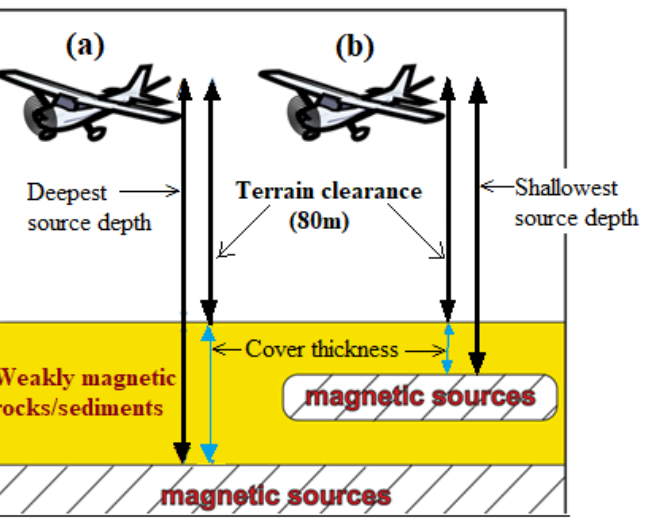
Figure 3. An illustration of the data acquisition for the high-resolution aeromagnetic data (HRAD), showing the depths to the top of ( a ) deepest magnetic sources and ( b ) shallowest magnetic sources.